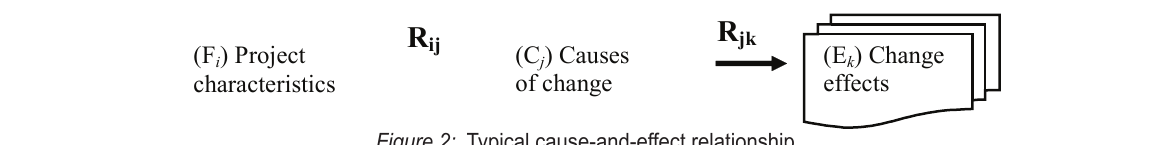
Figure 2: Typical cause-and-effect